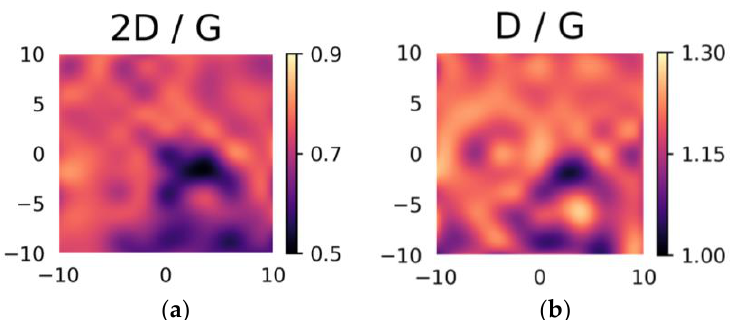
Figure 7. Maps of the Raman ( a ) 2D/G and ( b ) D/G intensity ratios recorded at the 442 nm excitation wavelength on a 20 × 20 µm 2 area of the pure graphene film annealed at 780 °C for 90 min (G-90). X - Y scales in µ m.